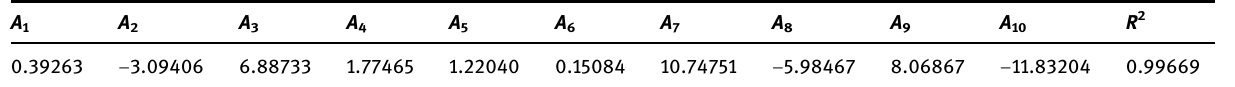
Table 9: Coe ffi cients of matching formula ( 26 ) to numerical results for SEN ( 4PB ) specimens dominated by plane strain